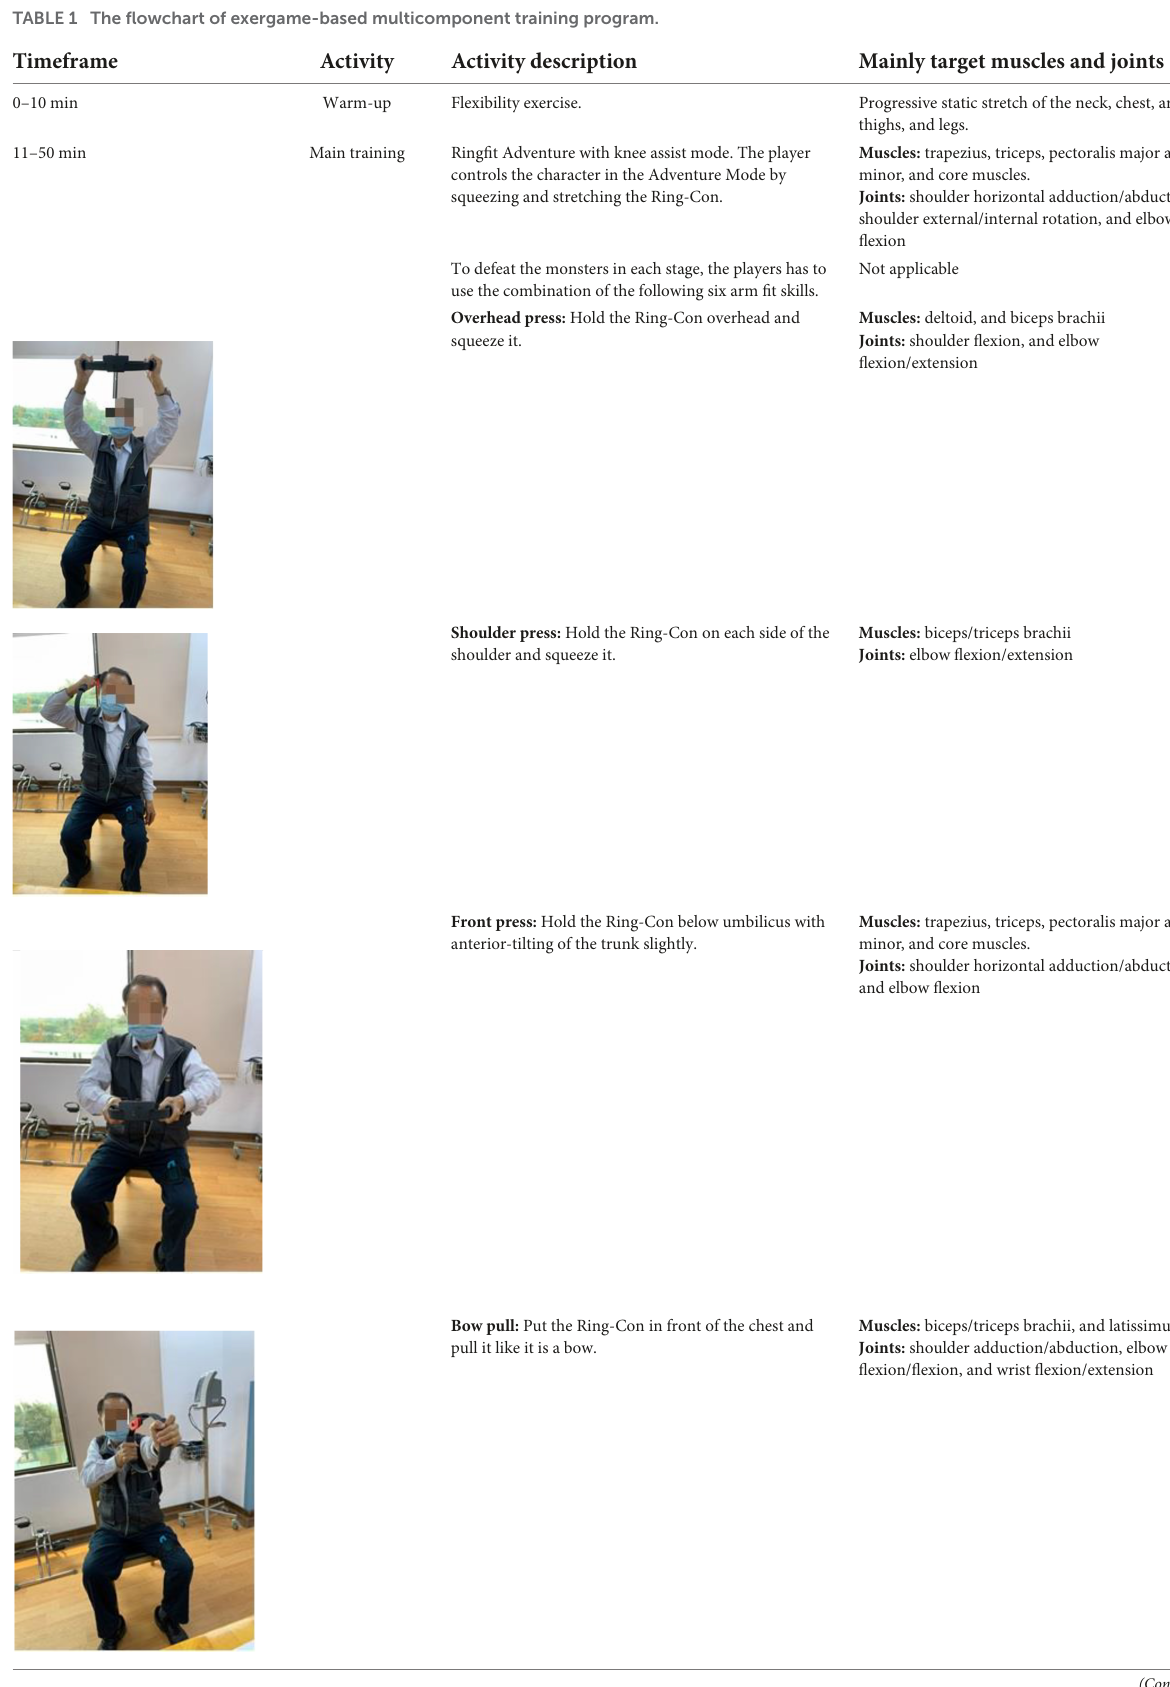
Bowpull: Put the Ring-Con in front of the chest and pull it like it is a bow.